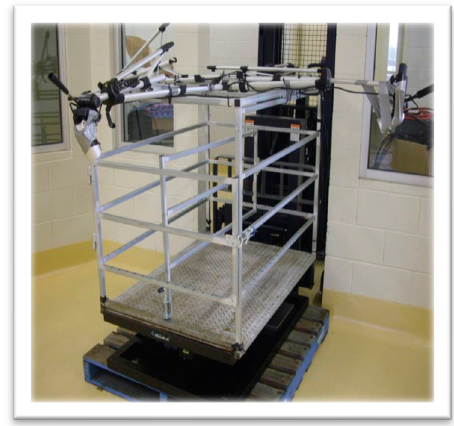
Figure 1. Platform and crate used to expose sheep to simulated ship movement.